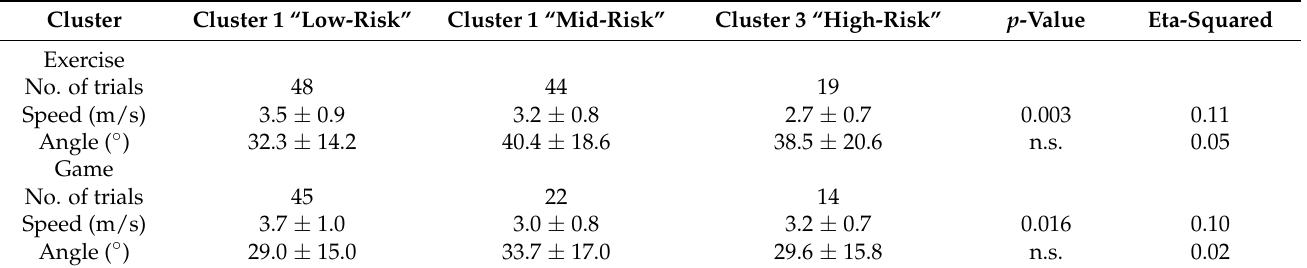
Table 1. Maximum speed and cut angle of the movement tasks performed on the field during exercise and game